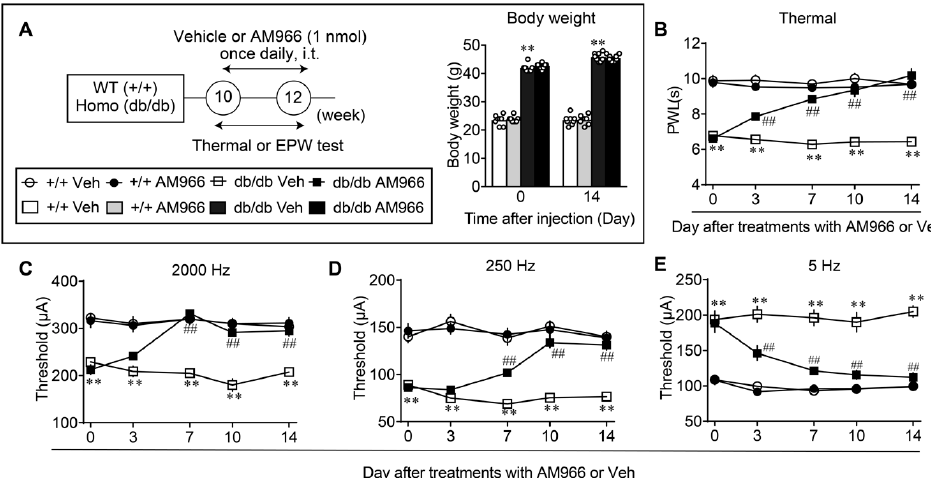
Figure 6. Reversal of abnormal pain behaviors in db/db mice by intrathecal treatments with LPA 1/3 antagonist. ( A ) Experimental schedule and lack of effects on the body weight by repeated treatments with AM966 (i.t.). ( B – E ) Effects of repeated treatments with AM966 on abnormal pain behaviors in WT and db/db mice. ** p < 0.01, vs. +/+ Veh, ## p < 0.01, vs. db/db Veh, three-way ANOVA followed by Tukey’s multiple comparisons test ( n = 8).